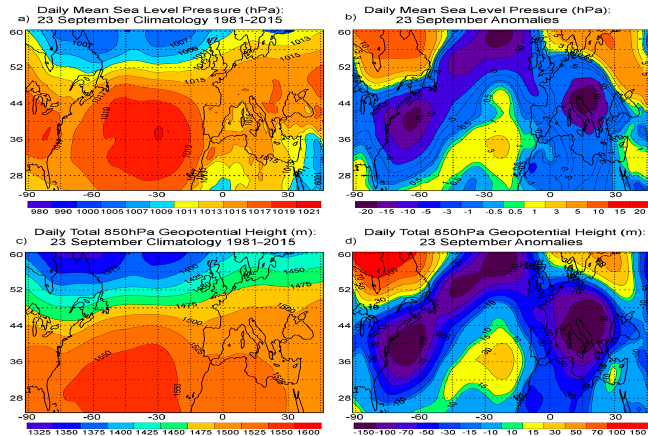
Figure 4. Top: Daily mean seal level pressure (SLP) for the day 23 September 1996 (measured in hPa). Bottom: Daily total geopotential height at 850 hPa, measured for the day 23 September 1996 (in geopotential metres, gpm). Left hand column ( a , c ) shows the climatology for 23 September 1981–2015 and right column ( b , d ) the anomalies. Data obtained from ERA-Interim at 1° degree in latitude and longitude.